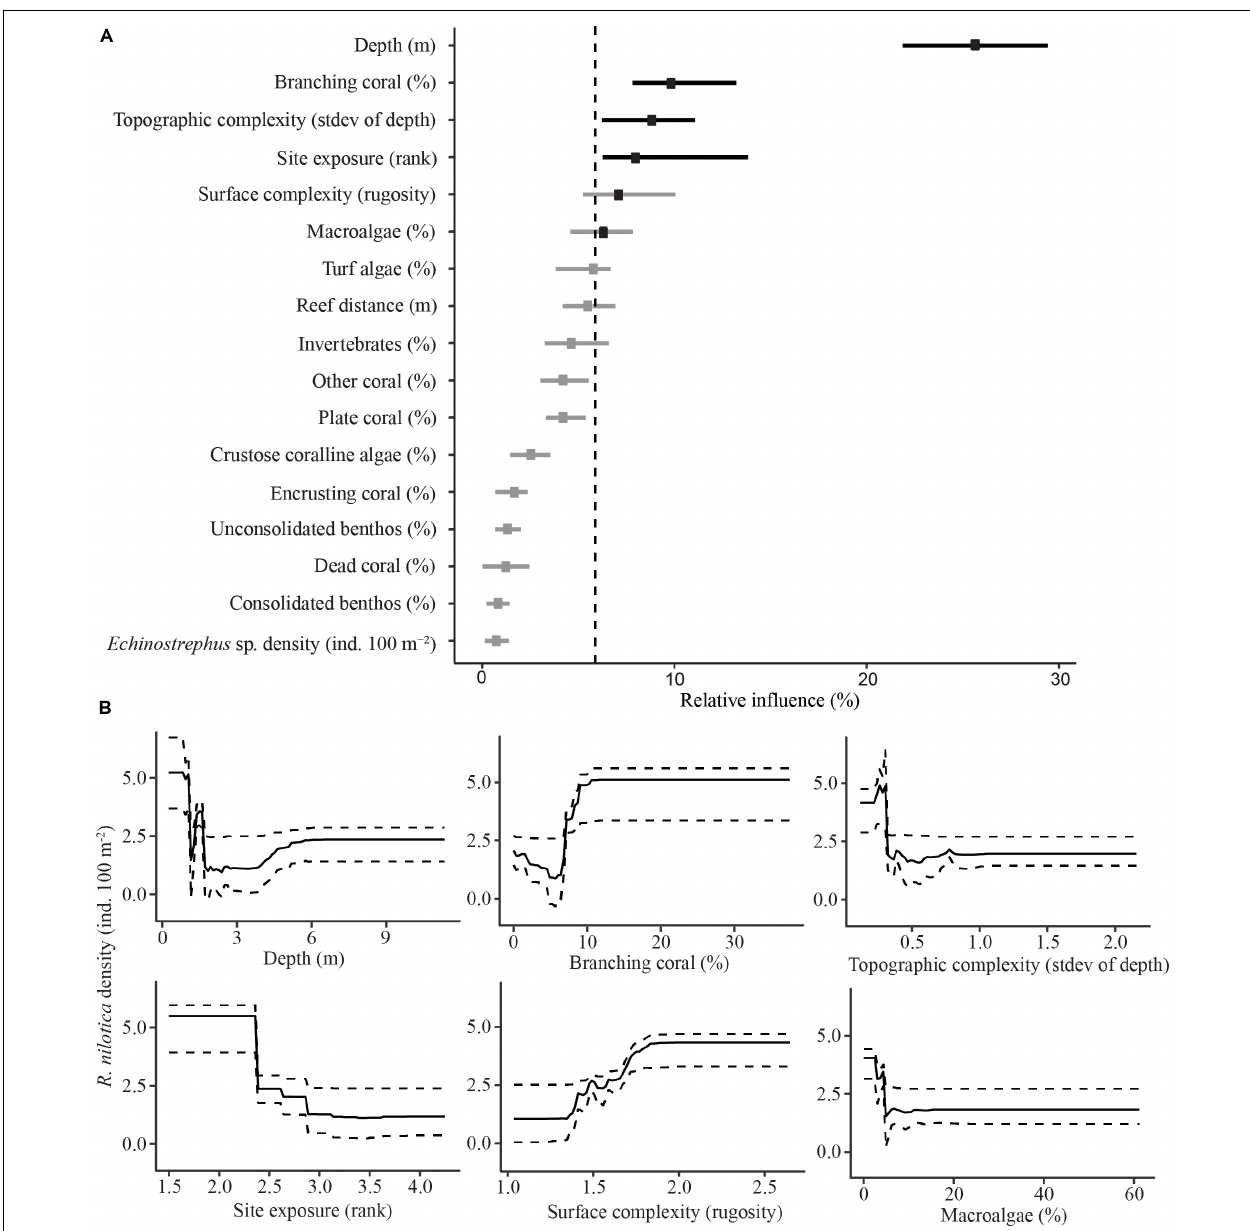
FIGURE 3 | Boosted Regression Tree relative influence plot for predictor variables of R. nilotica density (A) . Dots represent means for each predictor variable and bars represent upper and lower 95% quantiles. The vertical dashed line represents the significance threshold (100/17), variables exceeding the threshold are in black and those that do not are gray. Partial effects for significant predictor variables against R. nilotica density (B) . Solid lines represent means for each predictor variable and dashed lines represent upper and lower 95%